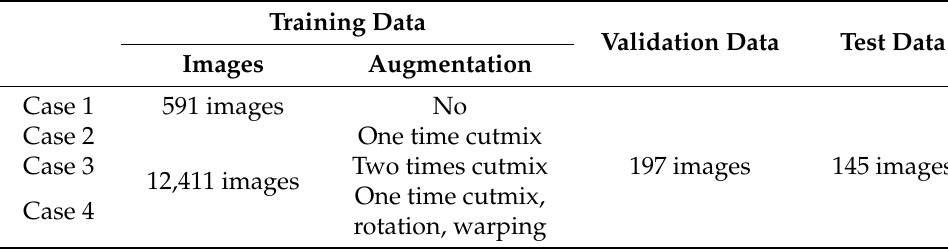
Table 1. Breakdown of images